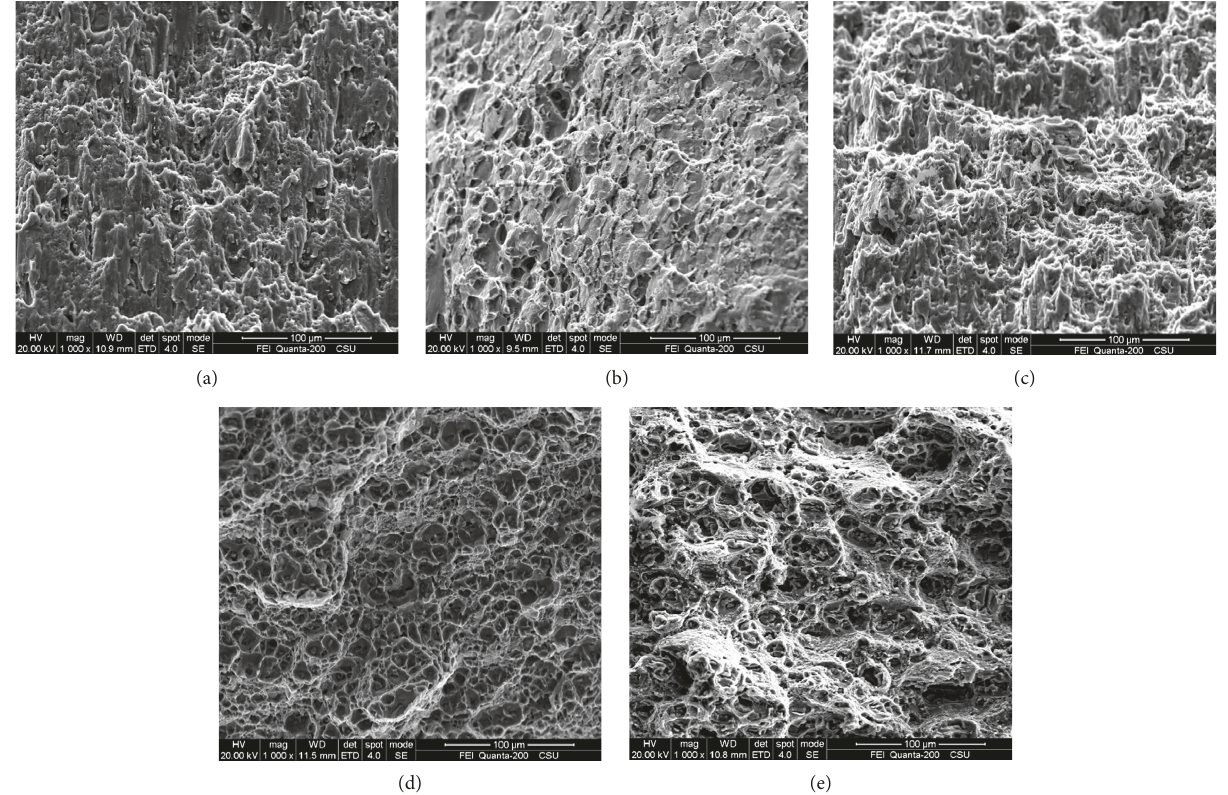
Figure 19: Fracture surfaces of (a) 0 ° , (b) 30 ° , (c) 45 ° , (d) 60 ° , and (e) 90 ° notch specimens.